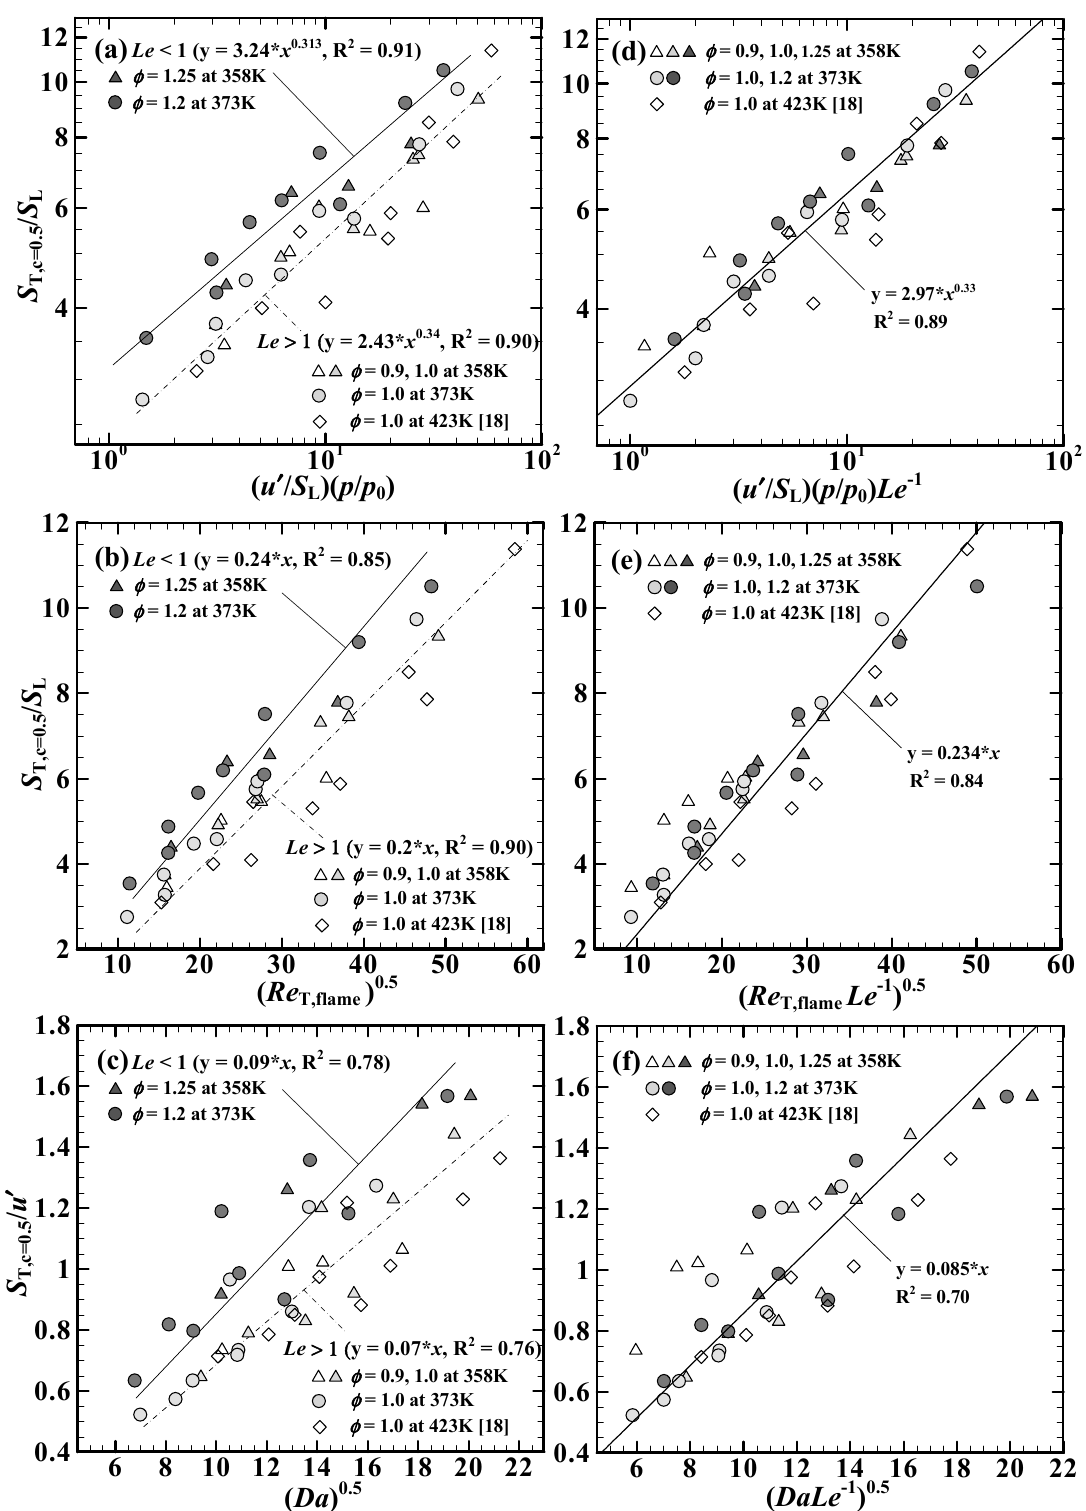
Figure 7. Left column: Normalized turbulent burning velocities for iso-octane/air mixtures plotted against three different scaling parameters: ( a ) ( u ′ / S L )( p / p 0 ) [8,19]; ( b ) ( Re T,flame ) 0.5 [12]; ( c ) ( Da ) 0.5 [10,11,16], all showing that Le < 1 flames propagate faster than Le > 1 flames having considerable data scattering. Right column: Same data from ( a )–( c ), but plotted against three modified scaling parameters grouped with Le –1 : ( d ) ( u ′ / S L )( p / p 0 ) Le –1 (Equation (2)); ( e ) ( Re T,flame Le –1 ) 0.5 (Equation (3)); ( f ) ( DaLe –1 ) 0.5 (Equation (4)), in which both Le < 1 and Le > 1 data sets are collapsed onto single curves.